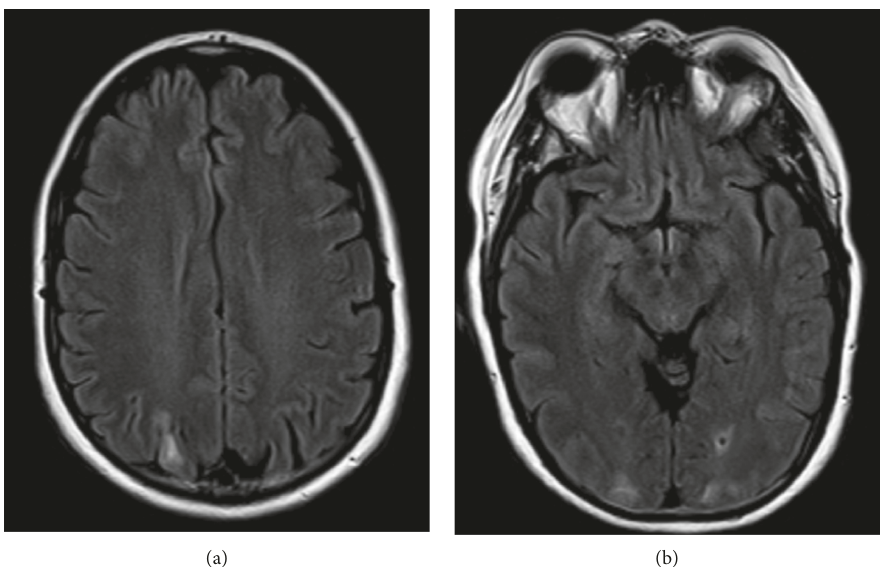
Figure 3: Axial FLAIR images of the brain demonstrating slight improvement of hyperintense signals in the (a) posterior right parietal lobe and (b) posterior occipital lobes bilaterally.